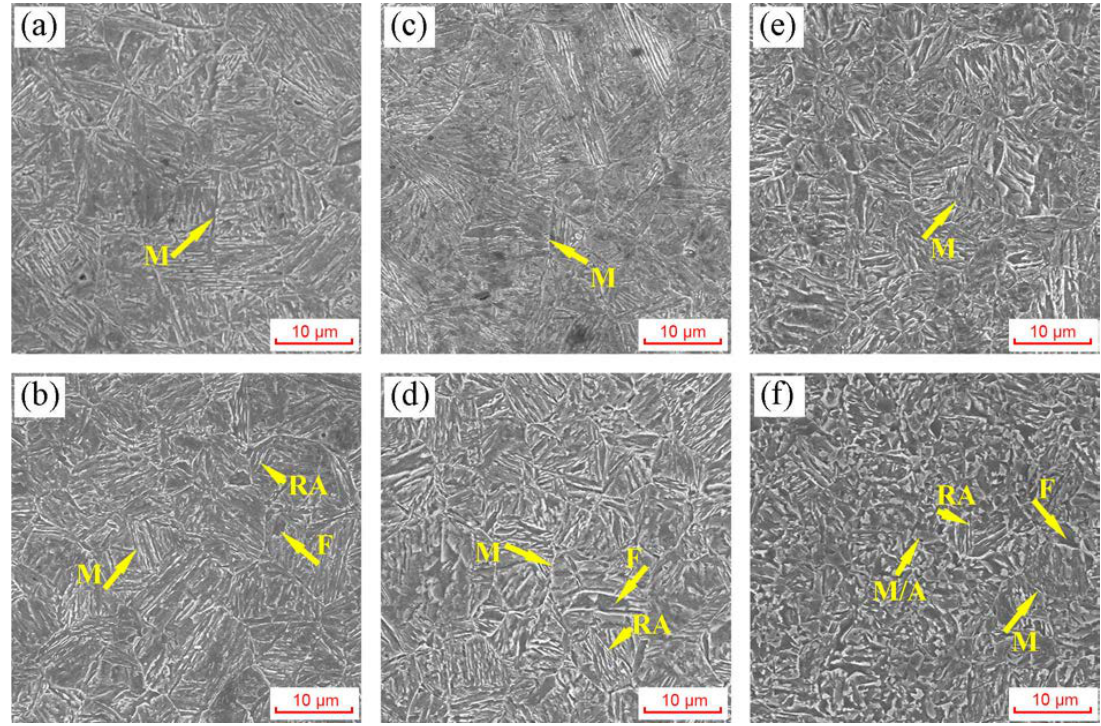
Figure 7. SEM micrographs of three steels after one-step Q&P treatment: ( a , b ) 0V, ( c , d ) 0.03V, and ( e , f ) 0.16V, partitioned for ( a , c , e ) 90 s and ( b , d , f ) 200 s. (M: martensite; F: ferrite; RA: retained austenite; M/A: martensite/austenite island.)